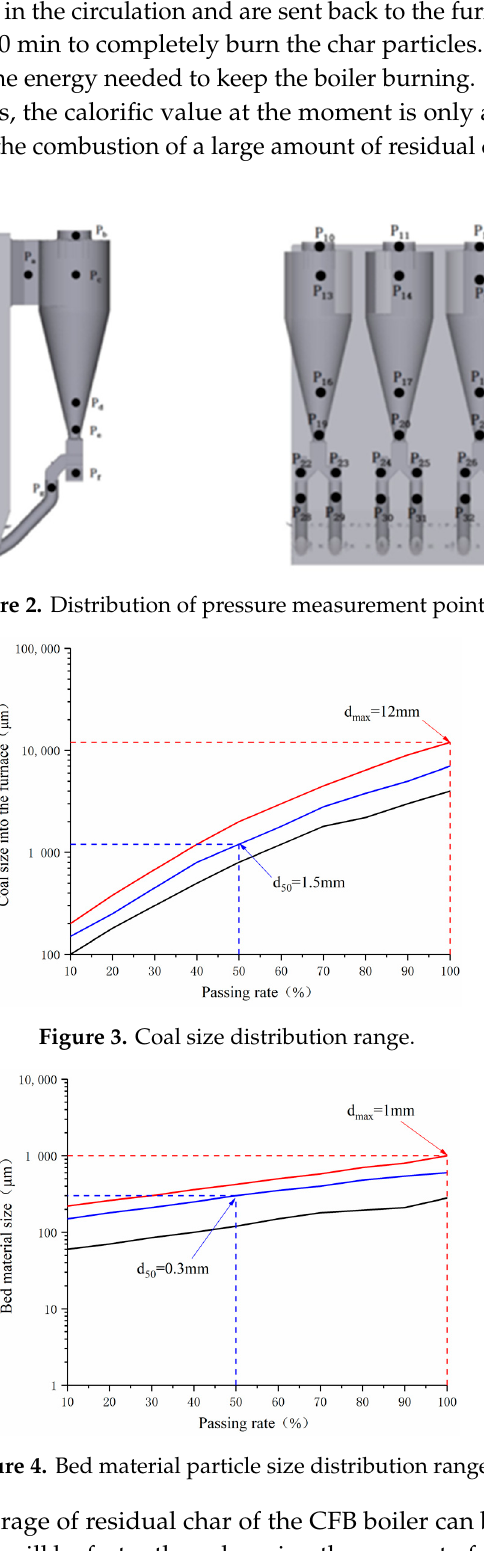
( b ). Computational particles Figure 5. Schematic diagram of real particles and computational particles. 3.1. Governing Equation The CPFD method uses the control volume method under staggered grid to achieve the dispersion of the equation. In the numerical simulation of the turbulent phase, a large eddy numerical simulation method is used, and the subgrid turbulence model is used to close the subgrid stress. The